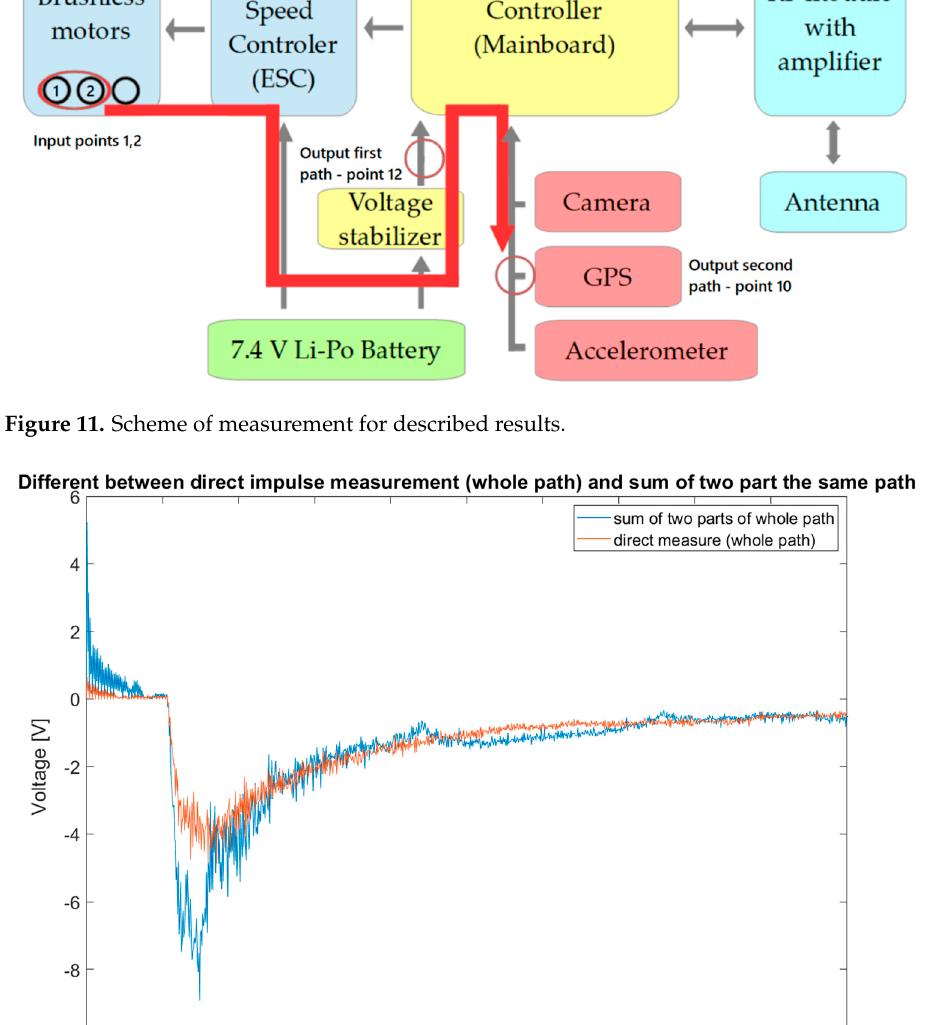
Figure 13. Measured overvoltage and simulated for the same circuits (three blocks). Input in points 1, 2 (motor coil) and output in GPS module communication line (point 10). For both examples, the shapes of measured pulses and calculated from model are similar. Distortions are only on the rising edge (there is a greater probability of noises or reflections in circuits). Amplitudes of both signals are different. For first example, the max- imum value of a model is greater than measured one, but only for the rising edge. The other parts of signals are similar. For the second example, the whole amplitude of the measured signal is greater than the calculated one (different by 25%). The developed